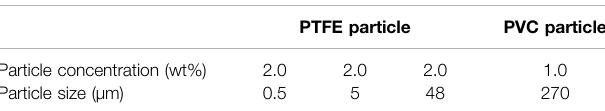
TABLE 2 | Parameters of particles in experiments.